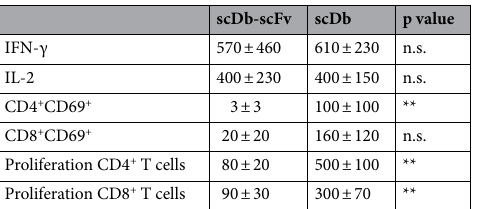
Table 2. T-cell activation of scDb and scDb-scFv. EC 50 [pM], Mean ± SD, n = 3. *p < 0.05; **p < 0.01; n.s. p >